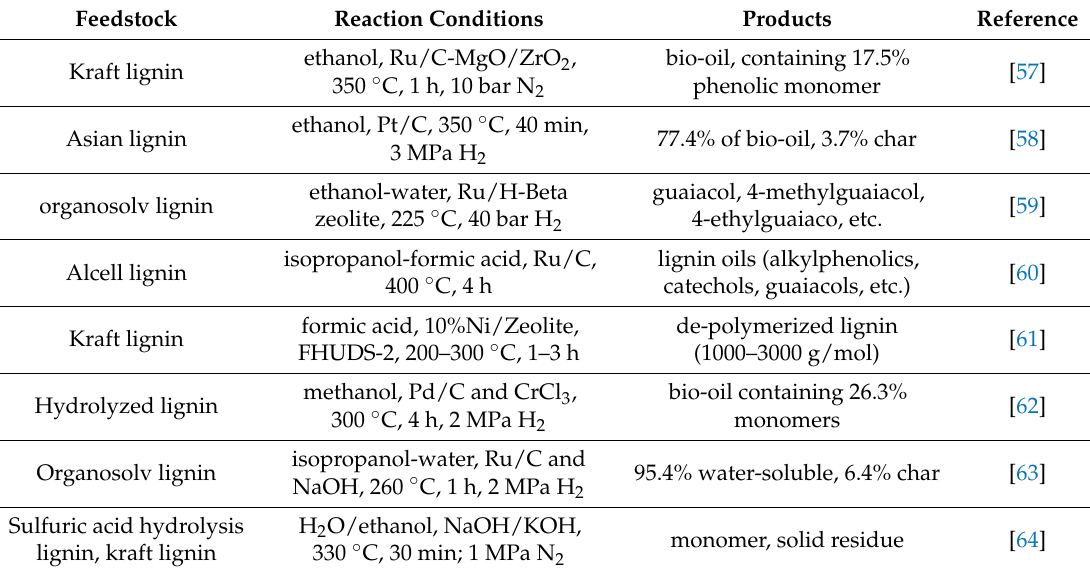
Table 2. Summary of conventional liquefaction of lignin under different reaction